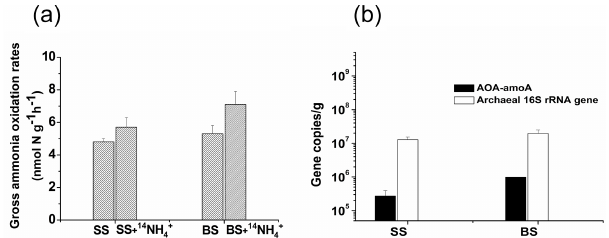
Figure 2. (a) Gross ammonia oxidation rates calculated from 15 N- ) or un- NO − pool dilution experiments on amended (added 14 NH + 3 4 amended SS and BS sediment slurries. This defines that the amend- ment with “ 15 NO 3 ” represents in situ nitrification activity, while 15 NO 14 NH 3 plus 4 is considered as potential nitrification activity. Bars represent the mean and standard error of the mean ( n = 3) for Figure 3. Epifluorescence photomicrograph of Crenarchaeota cells 30 and 120min incubation. (b) Abundance of archaeal 16S rRNA and cell aggregates. (White and red arrows show the cells and car- genes and archaeal amoA genes for SS and BS samples collected bonate crystals, respectively. Scale bar corresponds to from the Gongxiaoshe hot spring. Data are expressed as gene copies per gram of sediment (dry weight). Error bars represent the standard deviation of the mean ( n = 3).